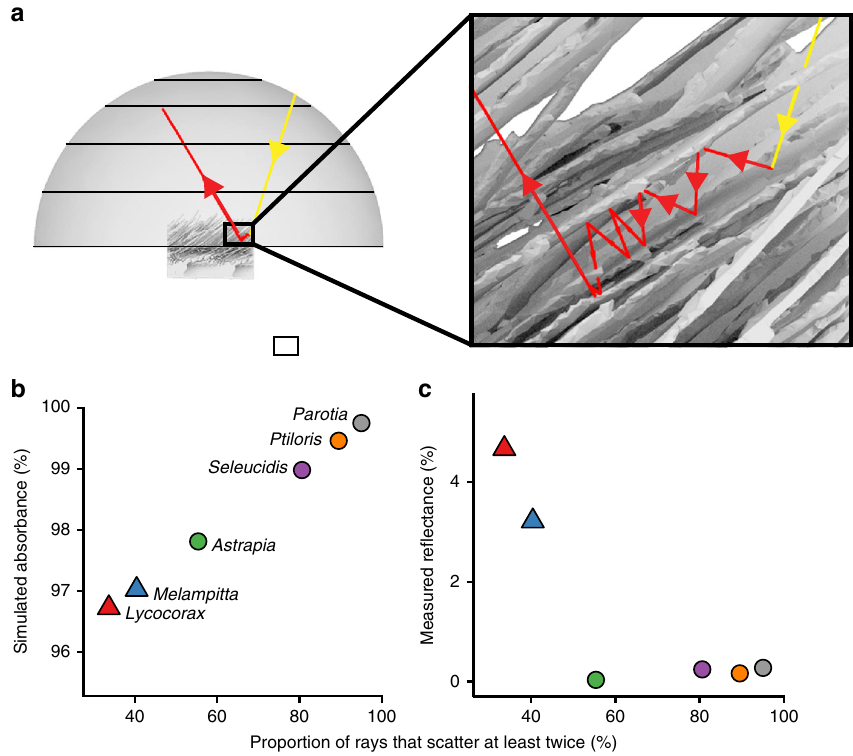
Fig. 4 Ray-tracing simulations. a Simulation from FRED showing the trace of a ray that scatters multiple times between barbules of a super black feather. b Substantial variation in frequency of multiple scattering events among species predicts variation in structural absorption. c Measured re fl ectance is signi fi cantly negatively correlated with the proportion of re fl ected rays that scattered at least twice (linear regression: R 2 = 0.68, slope = − 0.063, SE = 0.021, and P <